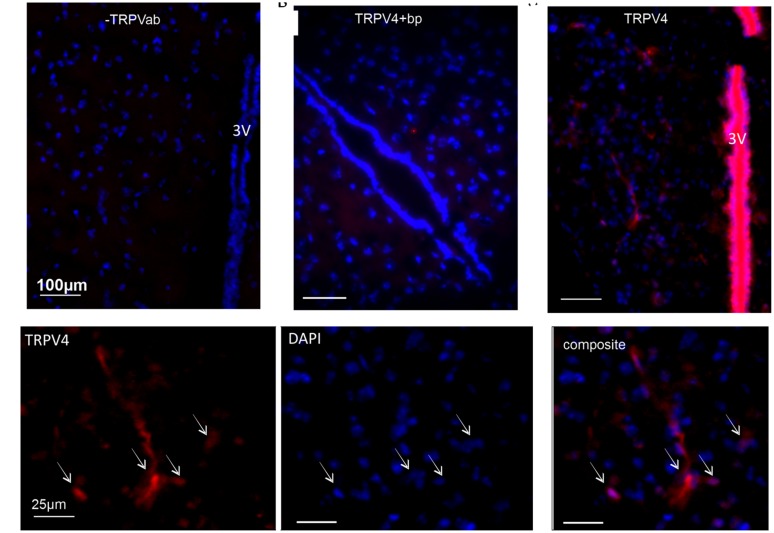
Immunofluorescent identification of TRPV4 in the paraventricular nucleus. PVN coronal slice labeled with antibody to TRPV4. (A) Negative control showing DAPI blue (a nuclear stain), with the absence of TRPV4 antibody staining (-TRPV4ab). Scale bar 100 μm and 3V indicates the third ventricle. (B) TRPV4 antibody applied together with a blocking peptide included (TRPV4 + bp). Red staining would indicate TRPV4 immunoreactivity, blue is DAPI nuclear staining. Scale bar 100 μm and 3V indicates the third ventricle.(C) Red staining indicates TRPV4 immunoreactivity, blue is DAPI nuclear staining. Scale bar 100 μm and 3V indicates the third ventricle. (D) High magnification images of the section seen in (C). Red staining is TRPV4 and blue is DAPI nuclear staining; arrows indicate where overlap can be seen. Scale bar is 25 μm in each panel.